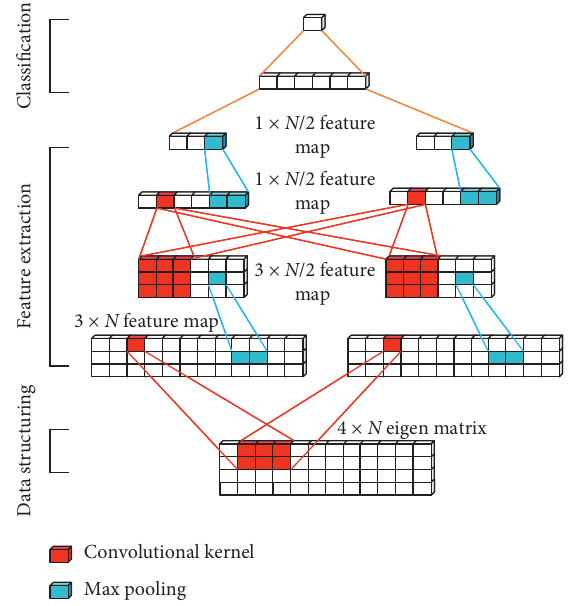
Figure 3: Framework of the temporal model based on